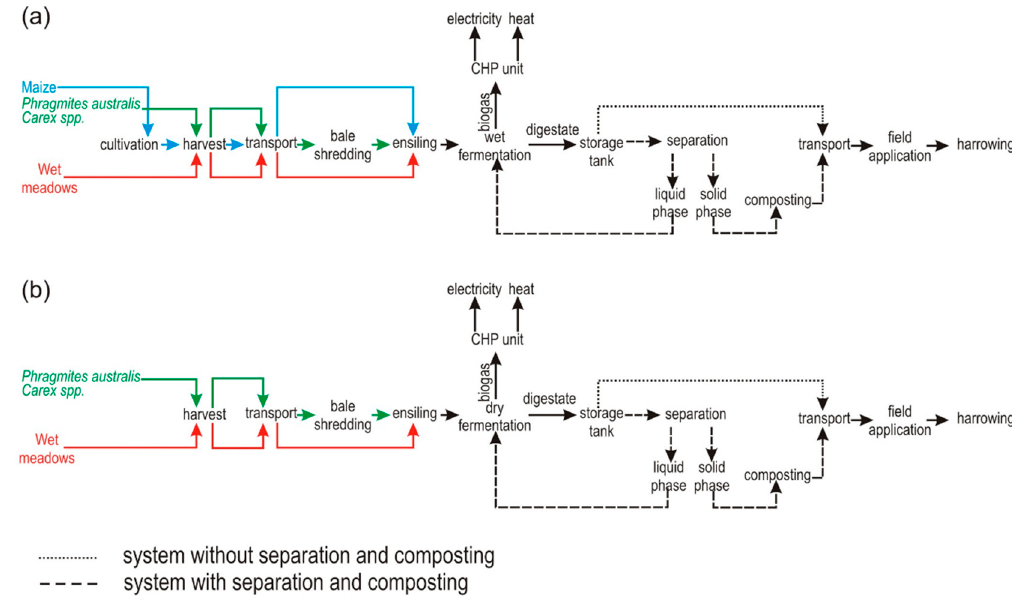
Figure 1. Simplified diagrams of analyzed systems of bioenergy production, including feedstock preparation, biogas production, and digestate utilization: ( a ) wet fermentation; ( b ) dry fermentation.